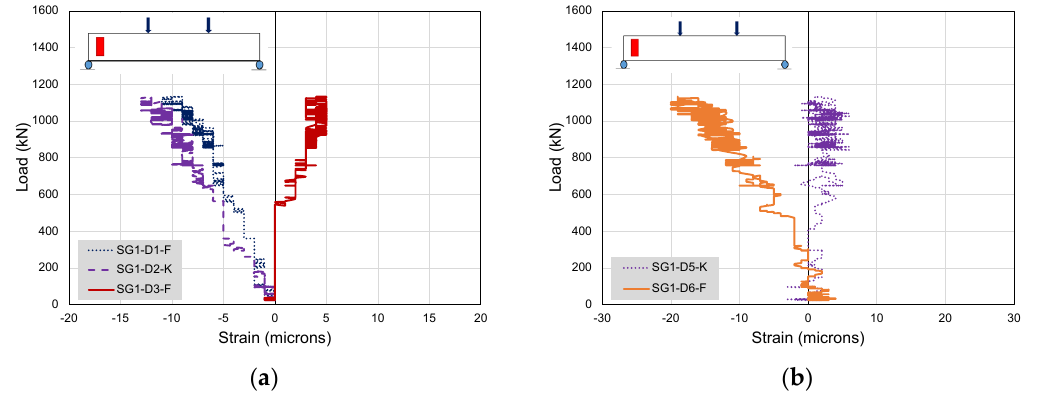
Figure 31. Load versus strain responses in load setup SP-3-L02 ( a ) D1-D3 and ( b ) D4-D6.